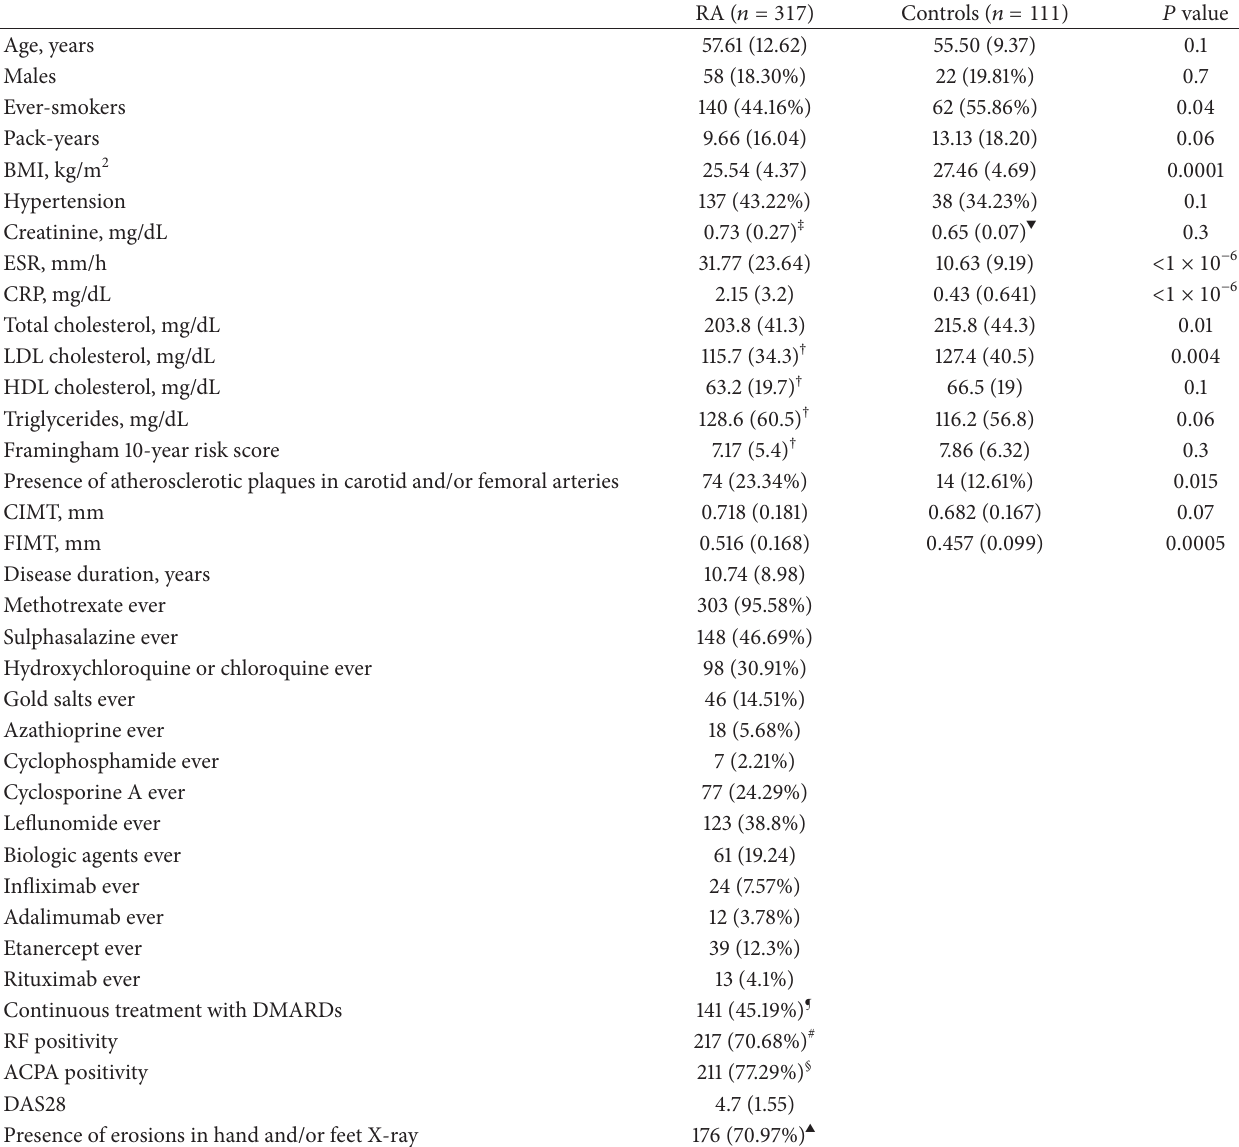
Table 1: Study and control group